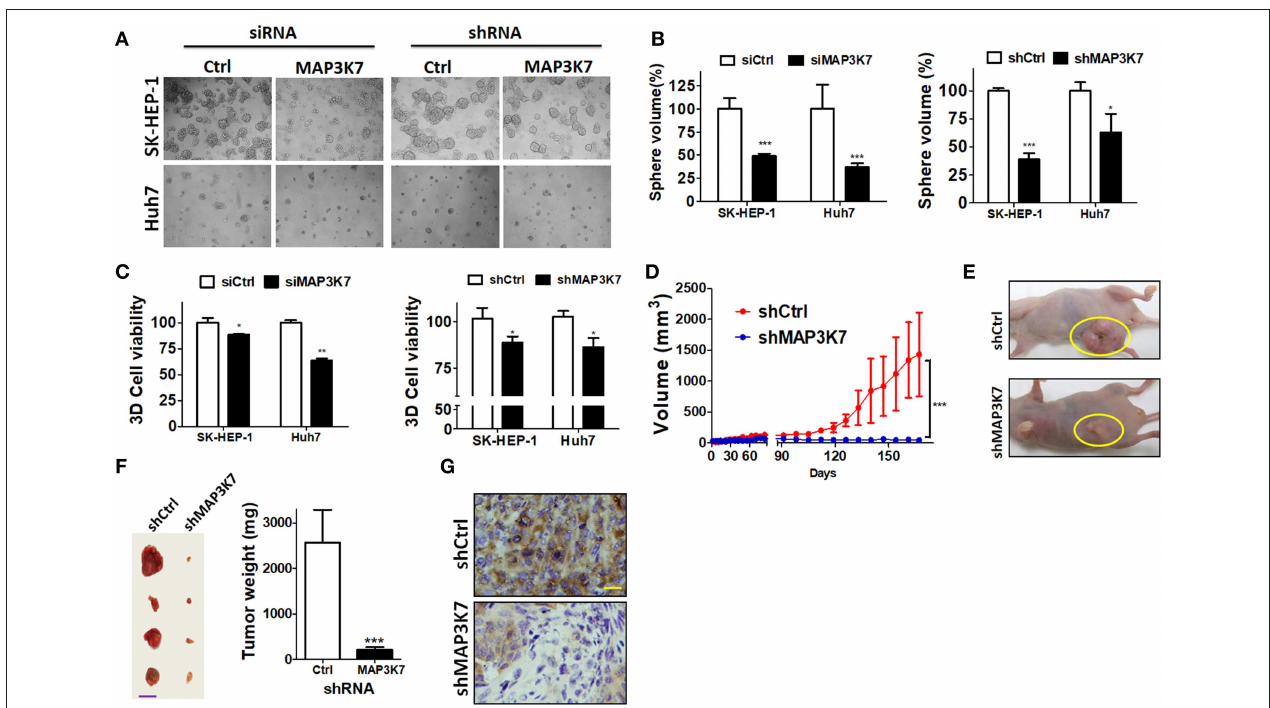
FIGURE 4 | Effects of silencing MAP3K7 on tumor formation of HCC cells in spheroid culture and xenograft mouse models. (A) SK-HEP-1 and Huh7 cells harboring siRNA or shRNA against MAP3K7 were grown on NanoCulture plates for 7 days to observe spheroid formation under a microscope. (B) Sphere volume was calculated from at least 100 spheres in each condition and normalized by cells with scramble shRNA. (C) Cell proliferation in the spheres was measured by a 3D CellTiter Glo assay and is expressed as a percentage compared with control cells. (D) Stably knocked down SK-HEP-1 cells were xenografted into nude mice, and tumor size was monitored every 3–4 days ( n = 5). (E) Representative images of xenograft tumors are shown. (F) The tumors were dissected from sacrificed mice and weighed. Representative tumors and quantitative results are shown. Scale bar: 20mm. (G) MAP3K7 expression in xenograft tumors was confirmed by